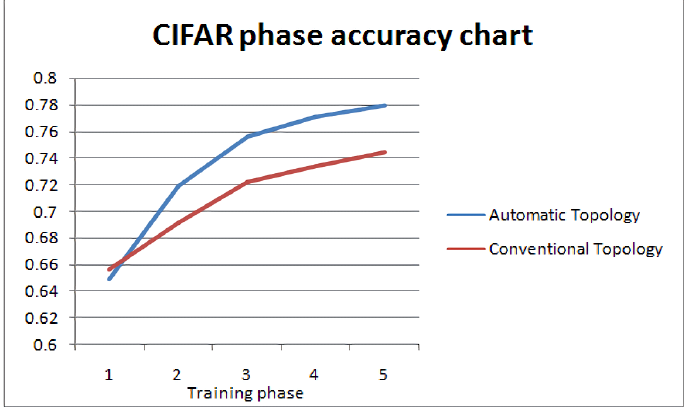
Figure 16. CIFAR-10 testing Accuracy chart per phase of topology